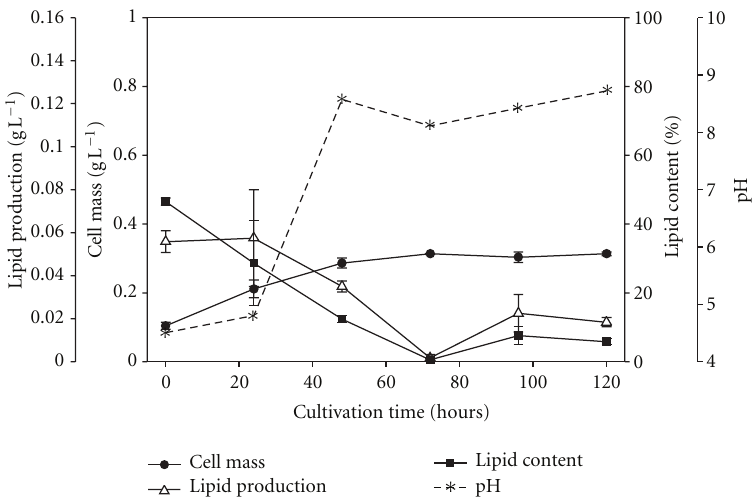
Figure 3: Cell mass production, lipid production, and lipid content of R. glutinis during cultivation on wastewaters from lettuce processing.